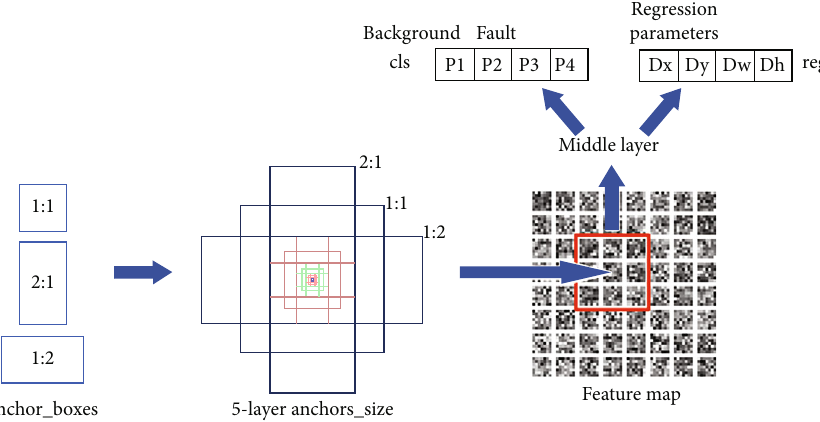
Figure 6: Region proposal network (RPN) and Anchor.